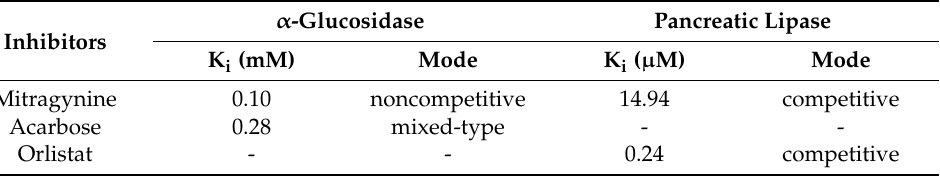
Figure 4. Lineweaver–Burk plots of α -glucosidase ( A – D ) and pancreatic lipase ( E – H ) in the presence and absence of kratom extracts, mitragynine, and positive controls (acarbose and orlistat). Table 5. Kinetic parameters in α -glucosidase and pancreatic lipase in the presence of mitragynine and positive controls.